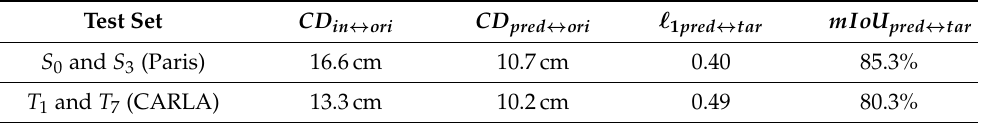
Table 6. Scene completion results on Paris-CARLA-3D. CD is the mean Chamfer Distance over 2000 chunks for the Paris test set ( S 0 and S 3 ) and 6000 chunks for the CARLA test set ( T 1 and T 7 ). (cid:96) 1 is the mean (cid:96) 1 distance between predicted and target TSDF measured in voxel units for 5cm voxels and mIoU is the mean Intersection over Union of TSDF occupancy. Both metrics are computed on known voxel areas. ori means original point cloud, in is input point cloud (10% of the original), pred is the predicted point cloud (computed from predicted TSDF).